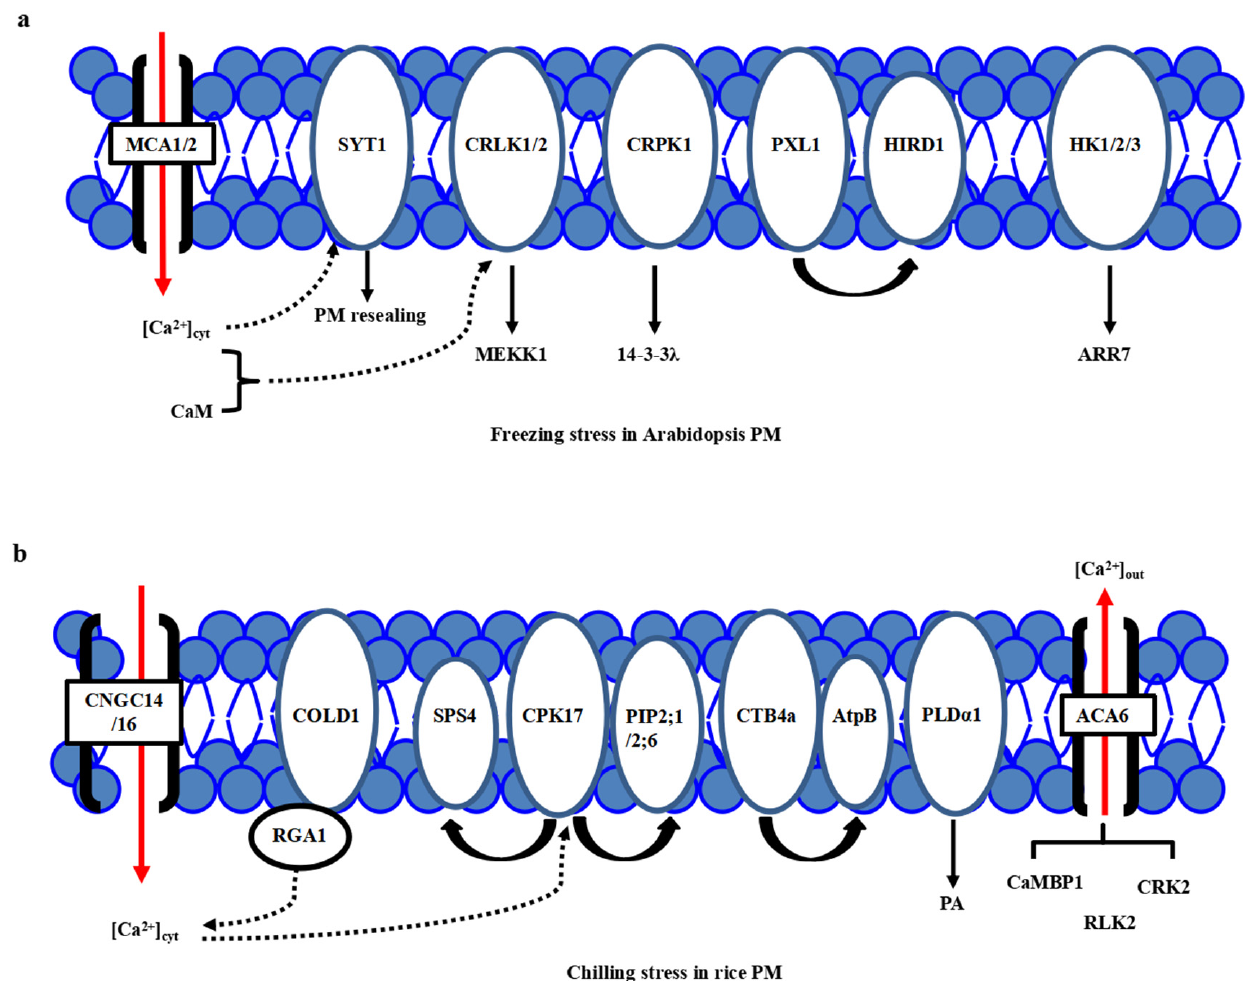
Figure 1. Plasma membrane-localized proteins perceive the cold stress signals in Arabidopsis and rice. ( a ) In Arabidopsis , freezing stress initiates the PM rigidification, PM-associated calcium channels MCA1/2, calcium sensor SYT1 and kinases including CRLK1, AtHK1/2/3, and CRPK1, as well as PM-localized PXL1, participate in primary cold stress sensing and perception. ( b ) In rice, chilling stress initiates the PM rigidification, many PM-associated proteins, including calcium channels ACA6, CNGC14/16, phospholipidase PLD α 1, aquaporin proteins PIP2;1/PIP2;6, G-protein-associated cold sensor COLD1 and kinases GT4a and CPK17, participate in primary cold stress sensing and perception. However, a specific calcium channel for calcium influx is still not known.